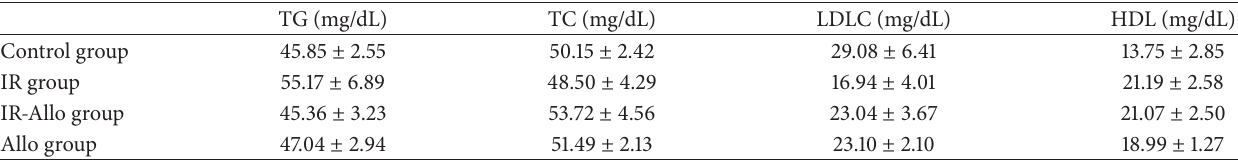
Table 2: The effect of allopurinol (Allo) treatment on insulin resistance (IR) lipoprotein profile including total cholesterol (TC), low density lipoprotein (LDL), triglycerides (TG), and high density lipoprotein (HDL-C) compared to control group. TG (mg/dL) TC (mg/dL) Control group IR-Allo group